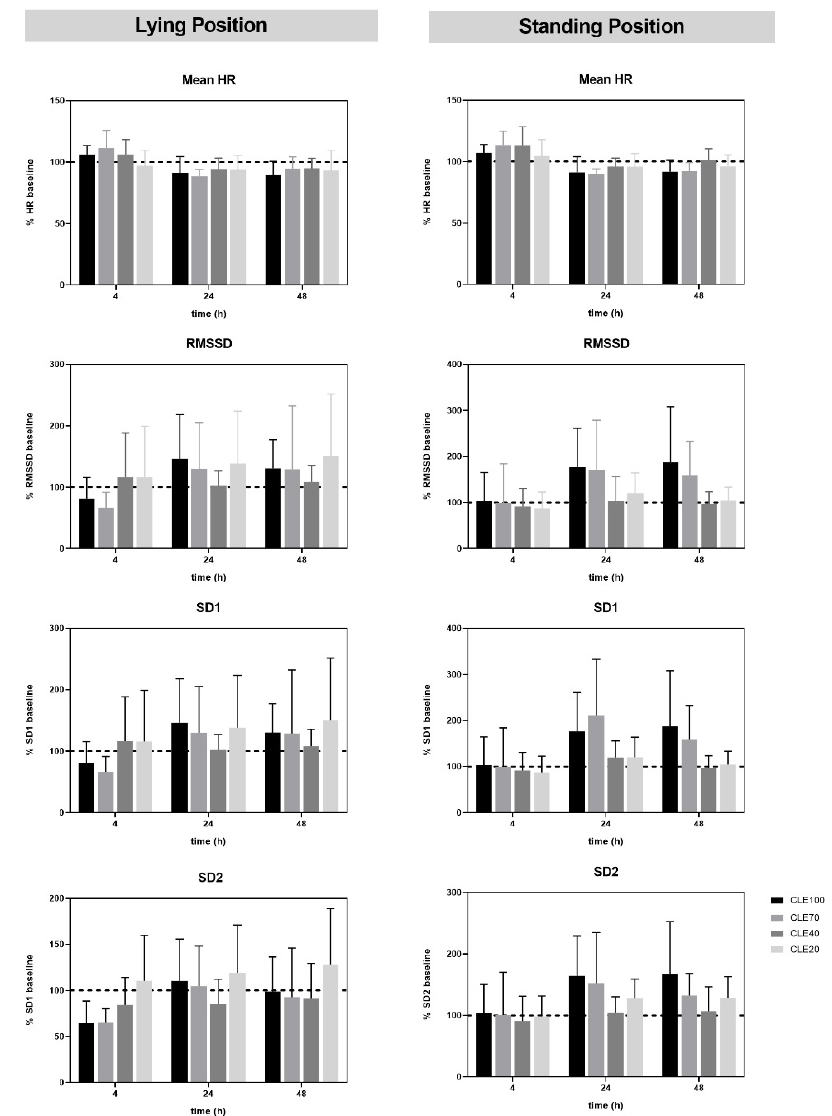
Figure 3. Percentage of baseline mean heart rate (HR) in lying and standing position, root mean square of successive RR interval differences (RMSSD), standard deviation of instantaneous beat-to- beat RR interval of Poincaré plot perpendicular to the line-of-identity (SD1) and along the line of identity (SD2) in lying and standing position measured 4, 24, and 48 h (Rec4, Rec24, Rec48) after four constant-load cycle ergometer exercise tests with maximum duration (CLE100) and 70, 40, and 20% of CLE100 (CLE70, CLE40, and CLE20) at the same intensity.